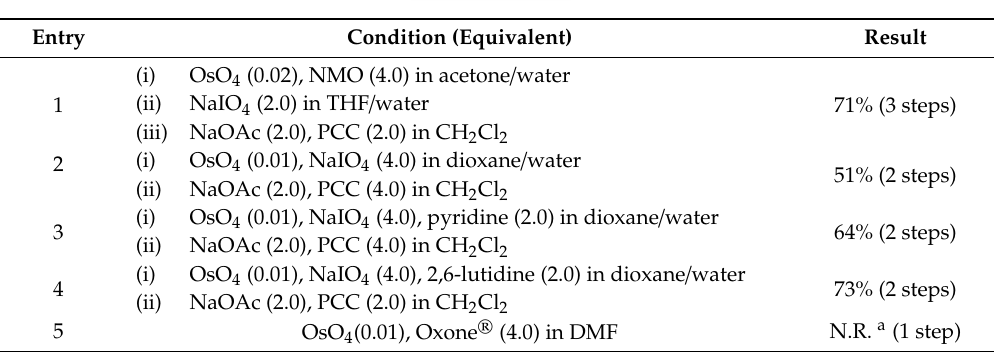
Table 1. Optimization of oxidative lactonization